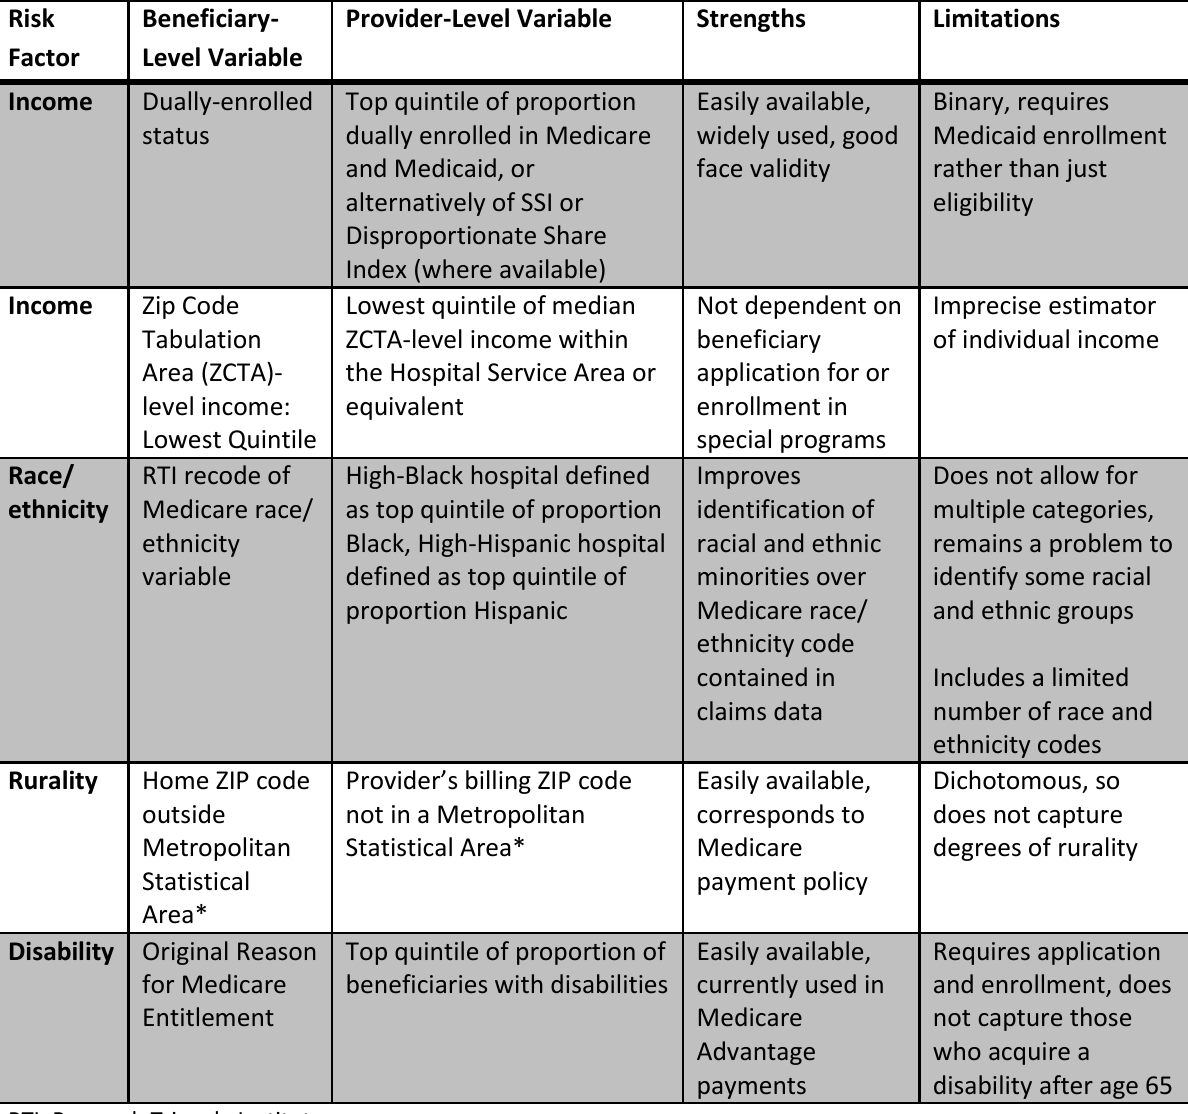
Table 2.1: Social and Related Risk Factor Study